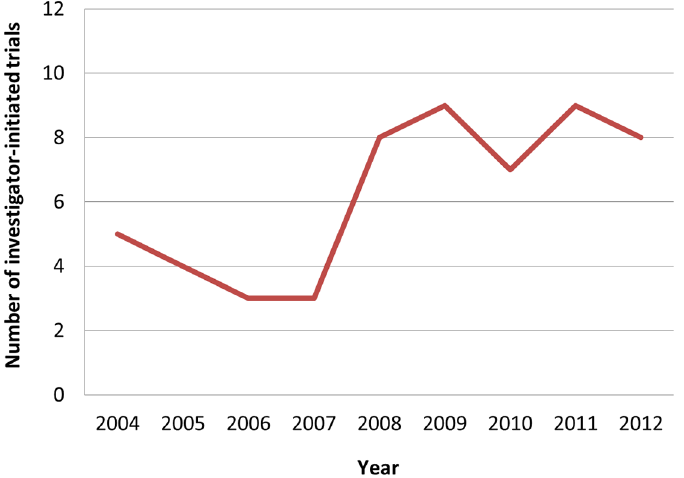
Fig 4. Number of investigator-initiated trials in Japanese registries. Curve represents the number of investigator-initiated trials from 2004 to 2012.